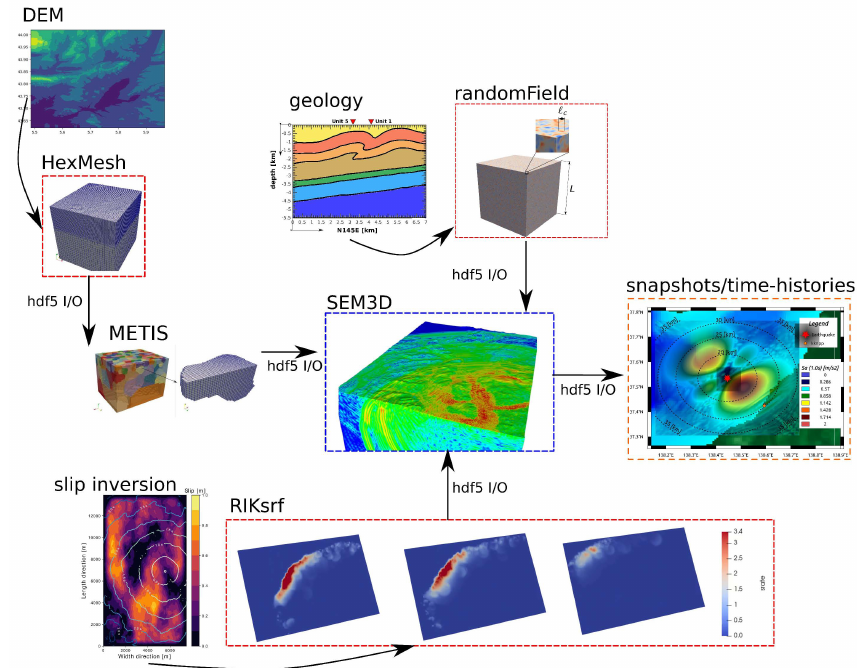
Figure 1. BBS2S flowchart. The wave-propagation kernel is represented by the HPC code SEM3D . The latter is fed by a hexahedral mesh, created with the software HexMesh , which extrudes the Digital Elevation Model (DEM), creating the connectivity matrix. The mesh is decomposed in subdomains by employing the open-source METIS library. The available geological information (interfaces, layers) is introduced and small heterogeneous fluctuations are added by using the library randomField , developed within the BBS2S project. The seismological information, represented by the available fault models (focal mechanism and slip inversion) are used to generate heterogeneous and broad-band slip distributions on a fault plane using the software RIKsrf . Topographical, geological, and seismological data are introduced into SEM3D via HDF5 library. The outcome is represented by regional snapshots and point-wise